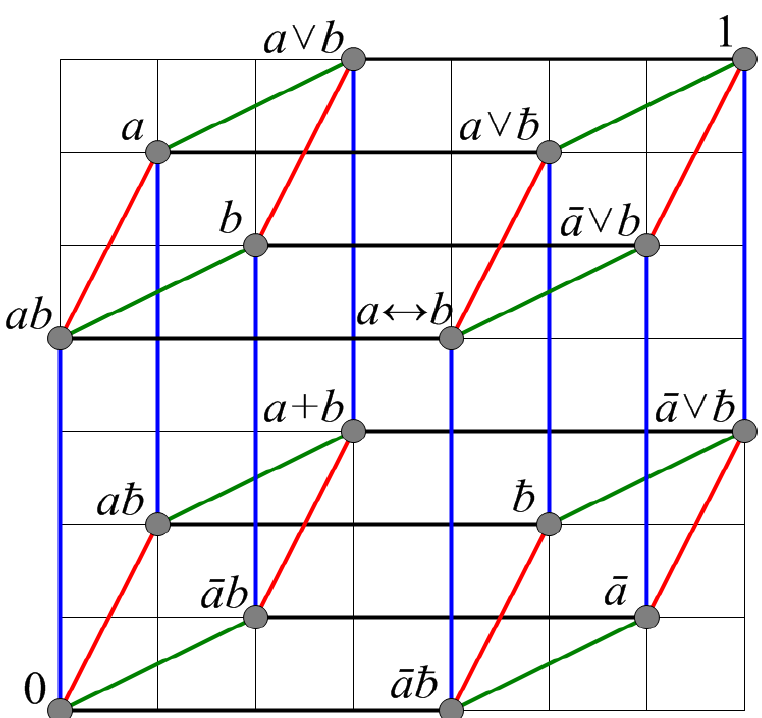
Fig. 2. A hypercube lattice indicating the partial ordering among the 16 elements of the 4-atom Boolean